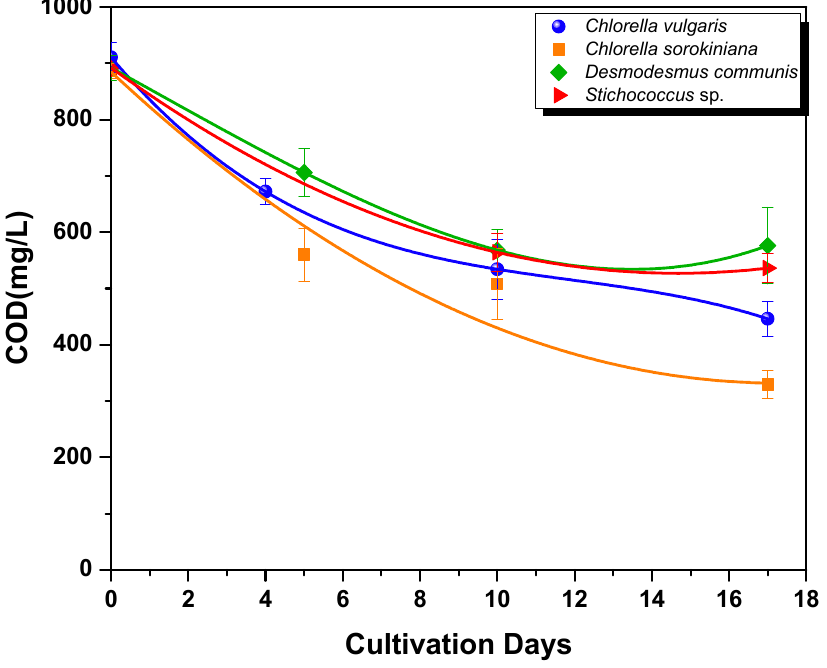
Figure 6. COD uptake in 3.7% ADE by microalgae.